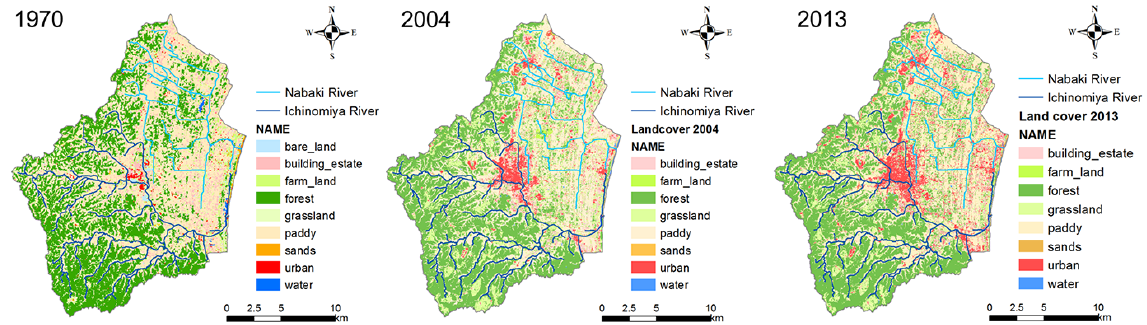
Figure 5. Land cover changes in 1970, 2004, and 2013. Land cover derived from Landsat-MSS and TM was classified by methods of maximum likelihood.